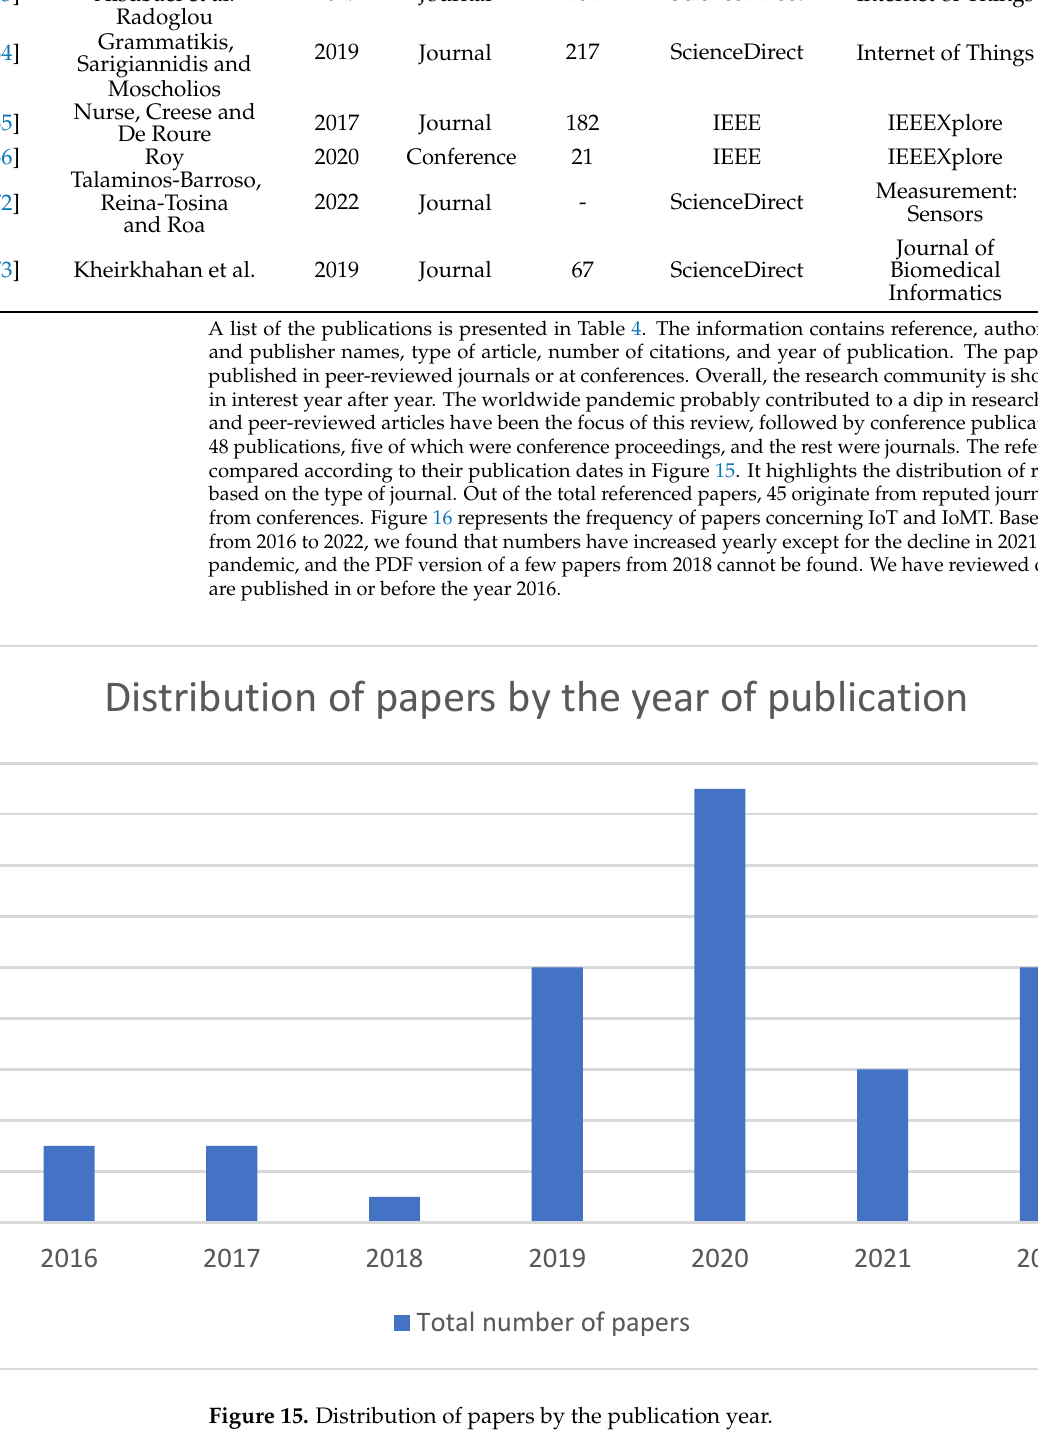
Figure 16. Distribution by the type of paper . 3. Methodology The objective is to identify and predict a framework for evaluating the risk associated with IoMT devices because of their immunity to security measures and a large number of